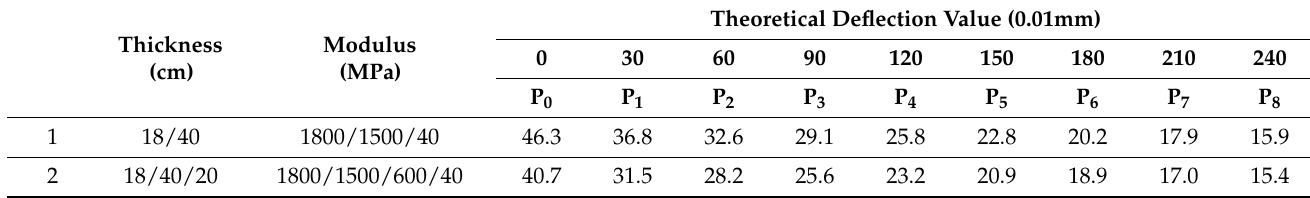
Table 3. The theoretical deflection curves calculated in